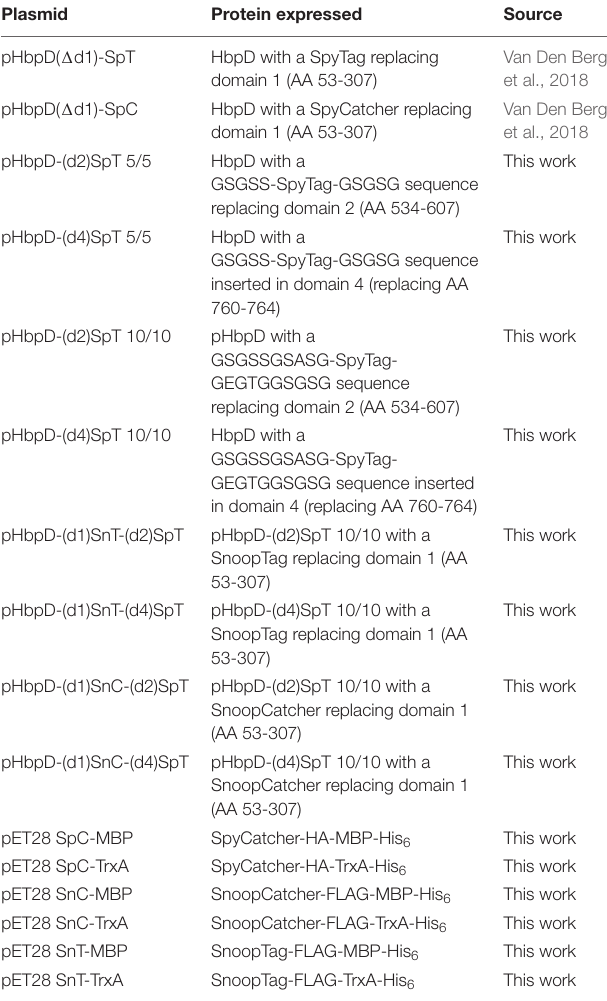
TABLE 1 | Plasmids used in this